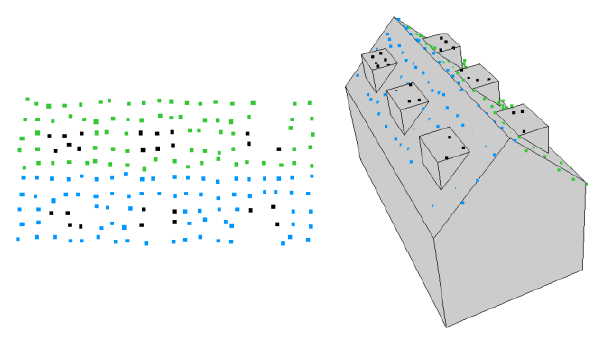
Figure 11. Left: Top view of the segmentation result. Unsegmented points are colorized in black. Right: The resulting building model reconstructed by our proposed